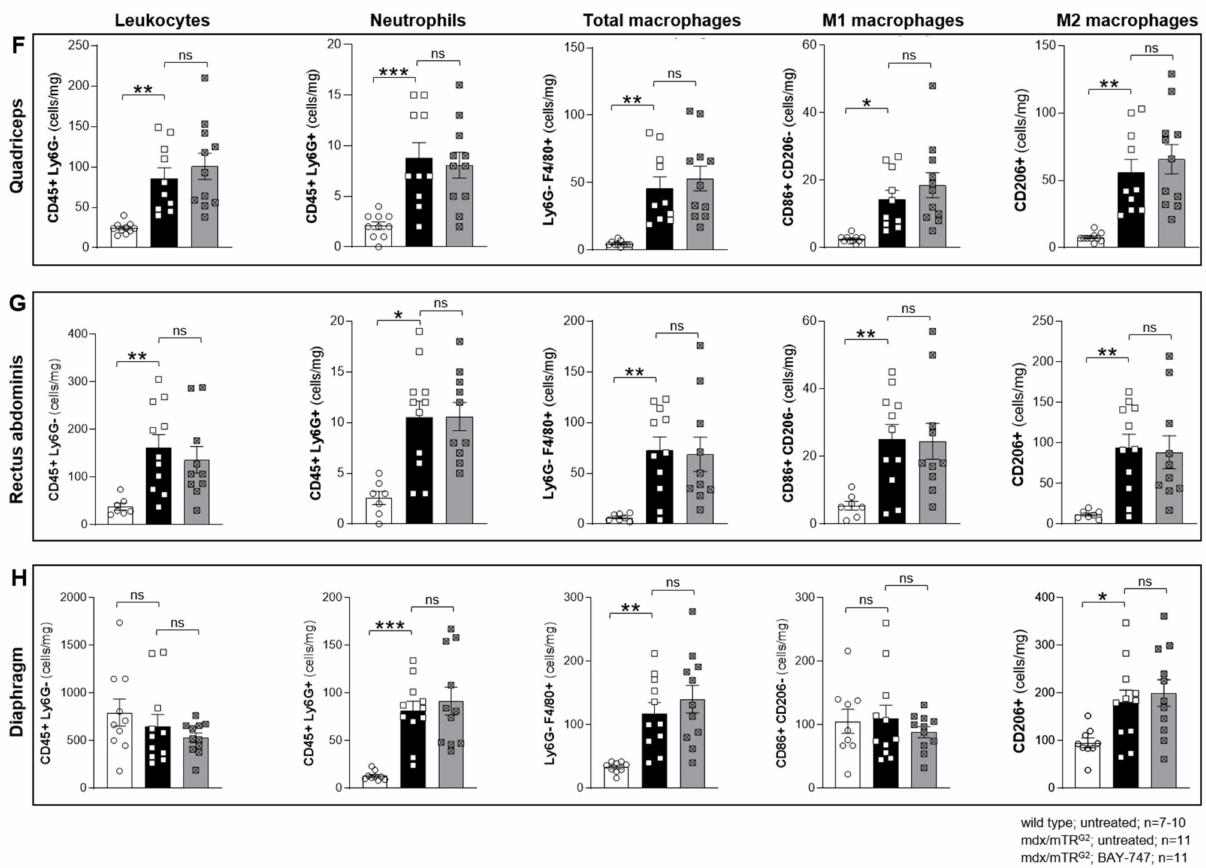
Figure 6. Treatment with BAY-747 on mdx/mTR G2 mice reduces expression of markers of inflammation at the gene level but not immune cell infiltration into the skeletal muscle. The effect of treatment with BAY-747 on levels of mRNA expression on pro-inflammatory genes ( A ) TNF, ( B ) SPP1, ( C ) IL-1 β , ( D ) IL-6 and ( E ) CCL2 in the quadriceps and immune cell infiltration of ( F ) quadriceps, ( G ) rectus abdominis and ( H ) diaphragm of mdx/mTR G2 mice. * p < 0.05; ** p < 0.01; *** p < 0.001; **** p < 0.0001; ns, not significant for one-way ANOVA followed by Dunnett’s multiple comparison post-hoc